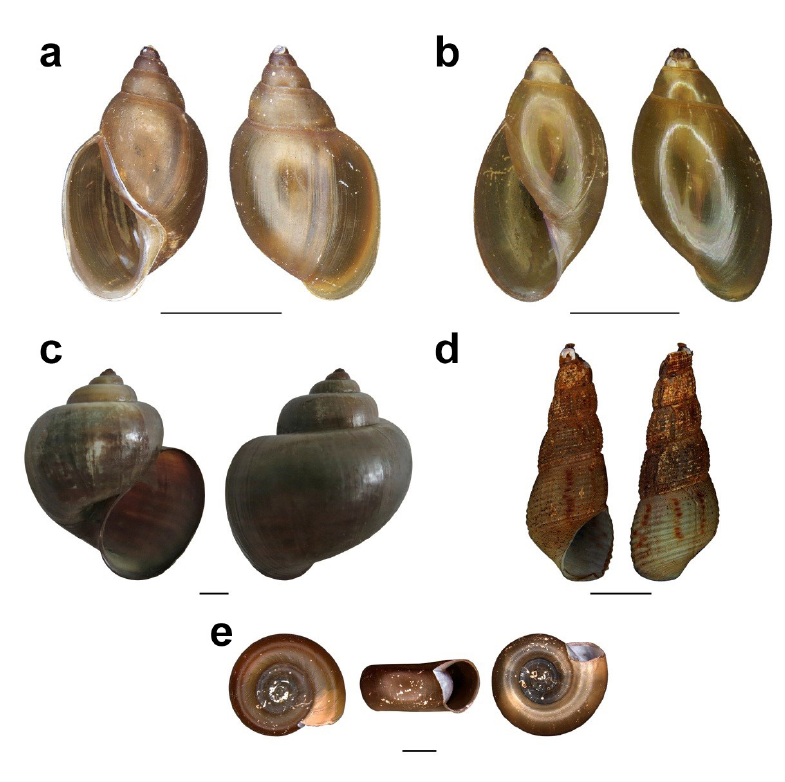
Figure 9. Shell in